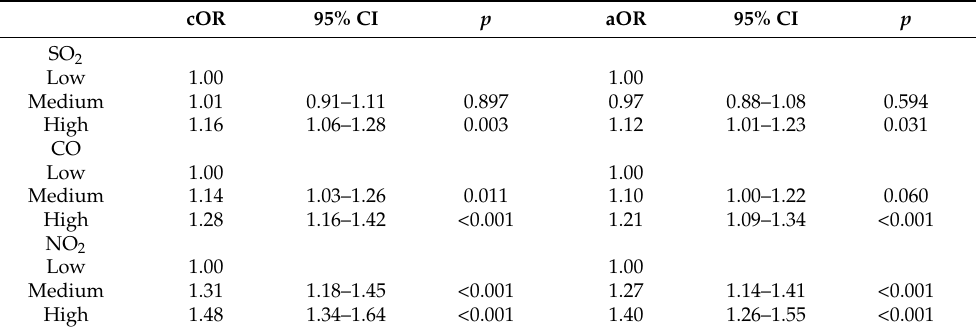
Table 4. Adjusted odds ratios for development delays and associated air exposure (without consider- ing low birth weight, premature birth, and Tourette